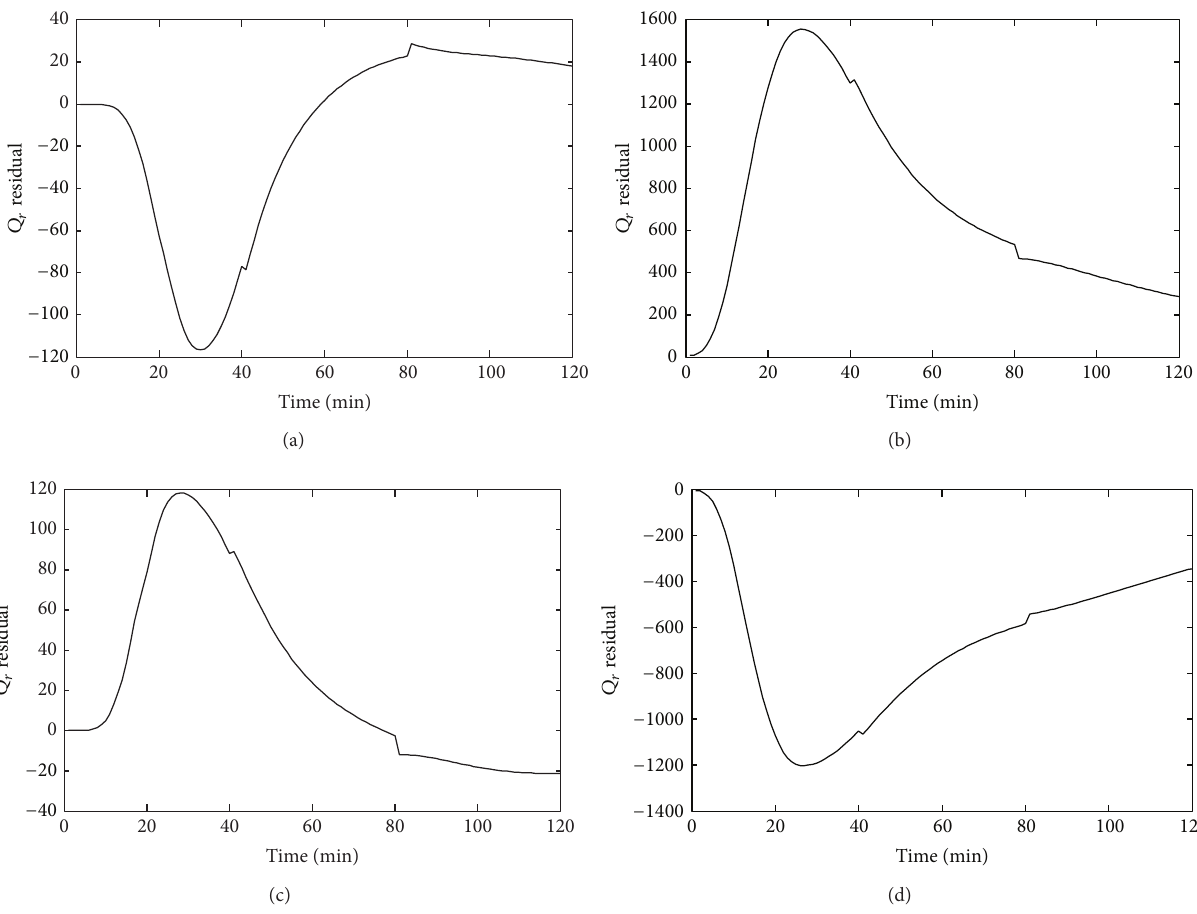
Figure 9: Residual (in terms of 𝑄 𝑟 ) due to change in heat transfer. (a) Residual (in terms of 𝑄 𝑟 ) due to 10% sudden increase in the heat transfer coefficient (𝑈) . (b) Residual (in terms of 𝑄 𝑟 ) due to 20% reduction in the heat transfer coefficient (𝑈) . (c) Residual (in terms of 𝑄 𝑟 ) due to 40% increase in the heat transfer coefficient (𝑈) . (d) Residual (in terms of 𝑄 𝑟 ) due to 30% increase in the heat transfer coefficient (𝑈)